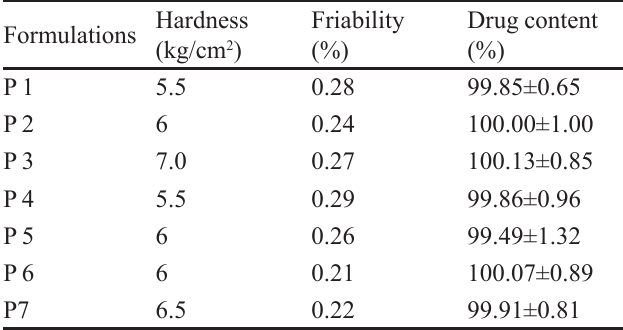
FIGURE 1 - Dissolution profiles of core tablets compared to marketed tablet (mean±s.d.,